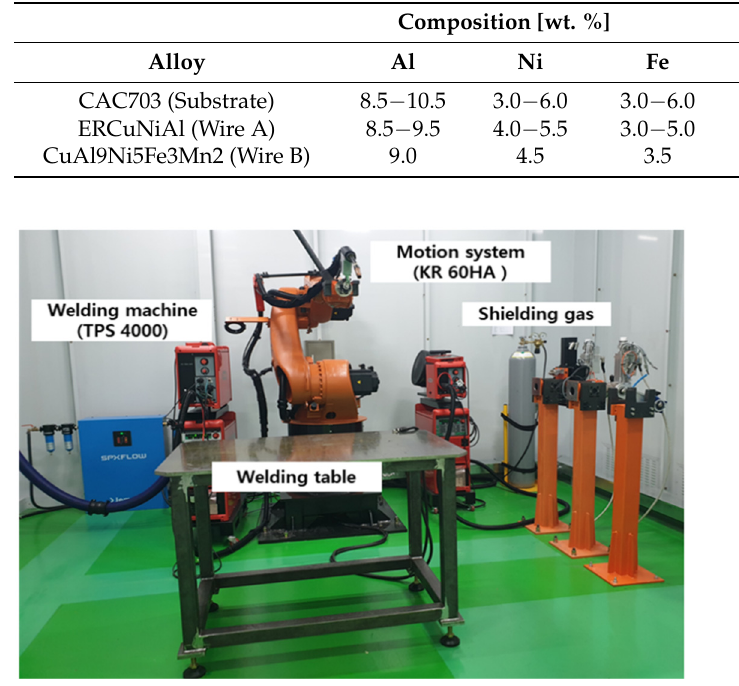
Figure 1. Wire arc additive manufacturing (WAAM) system adopted in the experiment. Table 1. Chemical compositions and mechanical properties of materials (wt. %) Composition [wt. %]